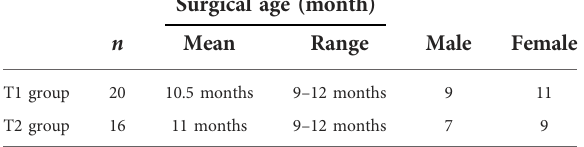
TABLE 1 Age and gender distribution of the